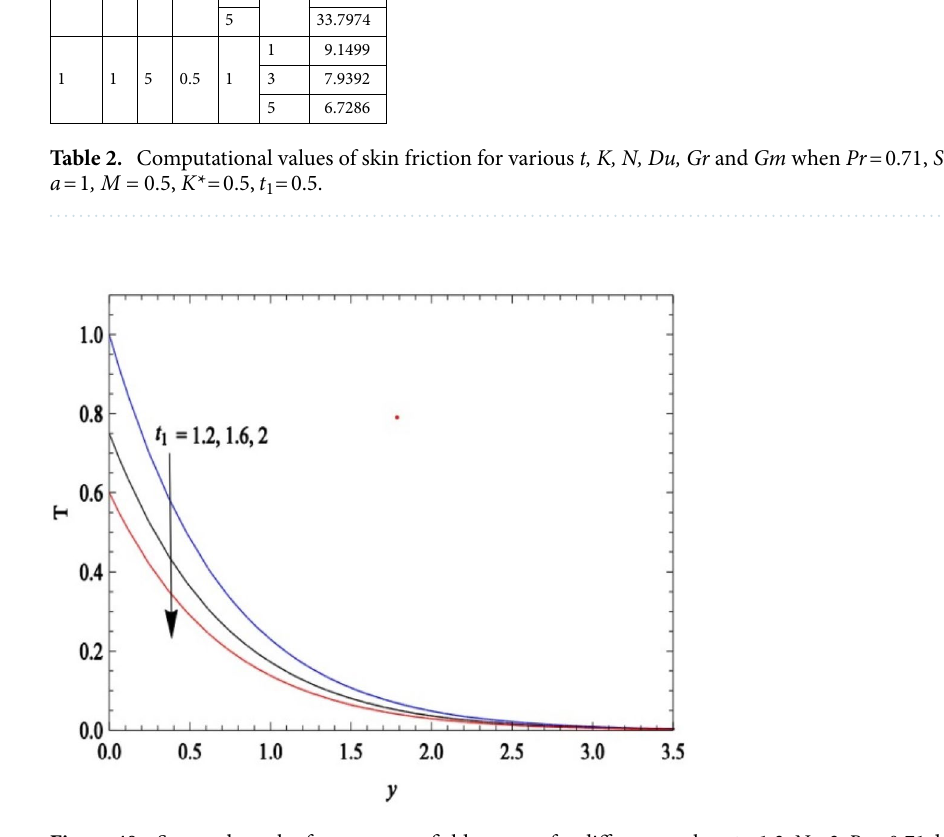
Figure 40. Scanned graph of temperature field versus y for different t 1 when t = 1.2, N = 2, Pr = 0.71 drawn by Seth et al. 49